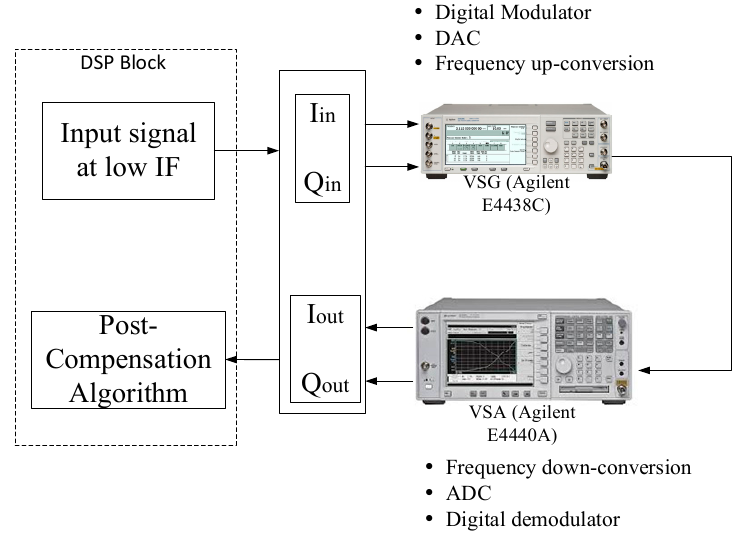
Figure 12. Measurement setup for evaluating the performance of proposed methodology.